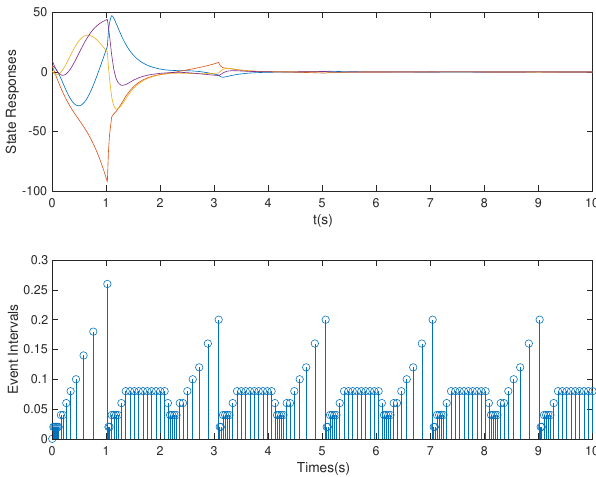
Figure 8. State responses and event intervals with DoS attacks ( p = 1 s) for